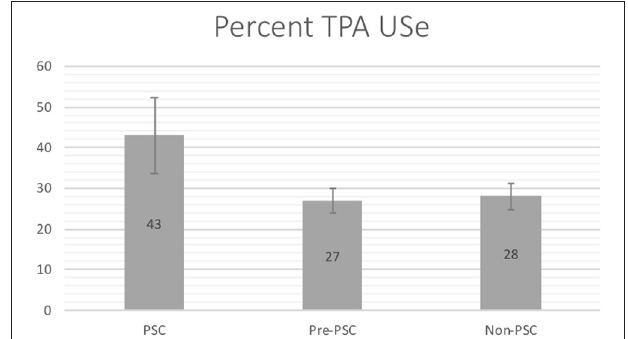
FIGURE 2 | Metrics of acute stroke care quality: tPA use in cerebral ischemia: mean rates of tPA utilization in cases of cerebral ischemia. Of 1,223 cerebral ischemia cases, rate of tPA utilization was 43% at PSCs, 27% at pre-PSCs, and 28% at non-PSCs ( p < 0.001, X 2 ). PSCs had a higher rate of tPA utilization in patients diagnosed with ischemic stroke.